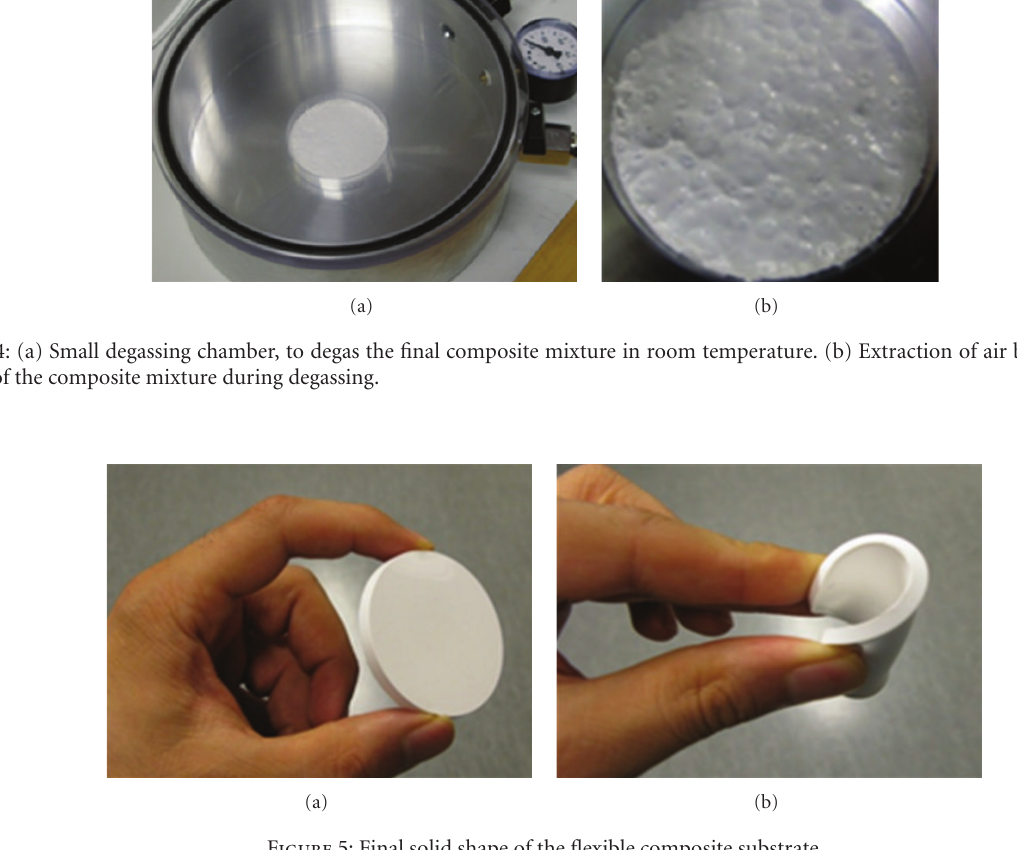
Figure 5: Final solid shape of the flexible composite substrate.